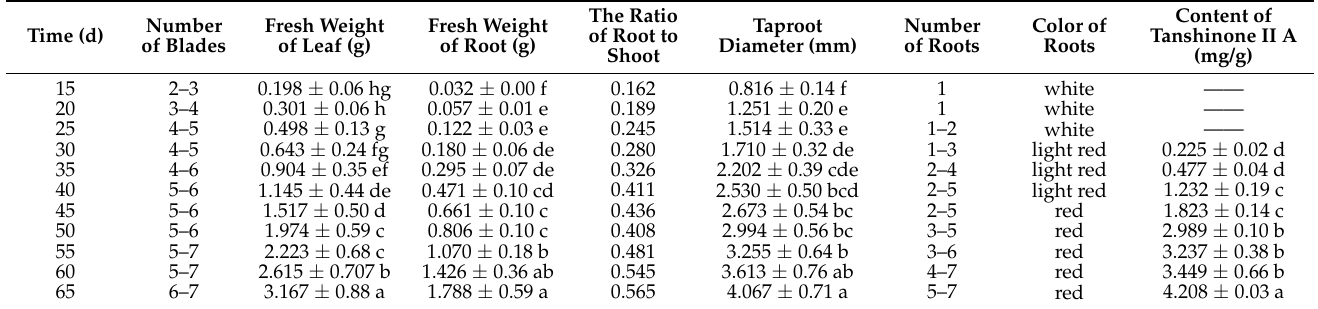
Table 1. Phenotypic characteristics of S.miltiorrhiza seedlings within 60 days of growth (mean ± SD, n =